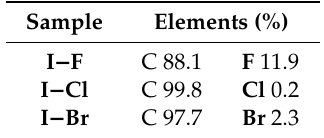
Table 3. Percentages of atoms (%) of the I − X